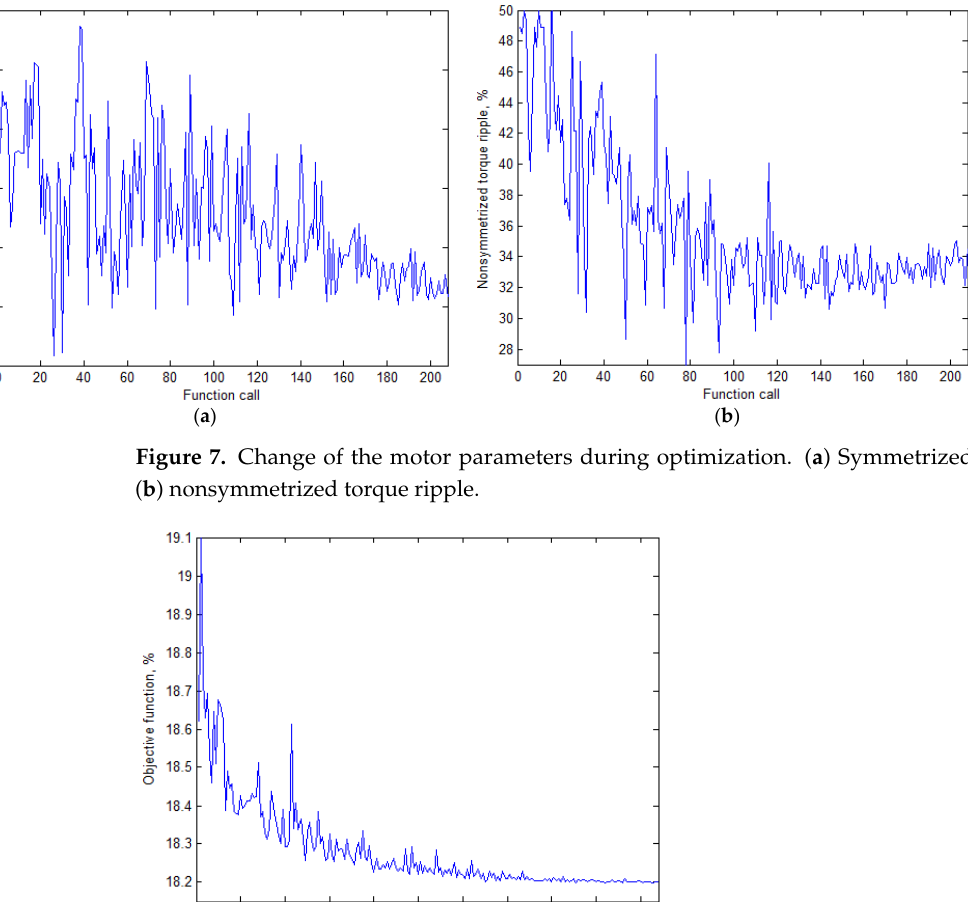
Figure 6. Change of the motor parameters during optimization. ( a ) Average losses; ( b ) maximum magnitude of the power winding current.